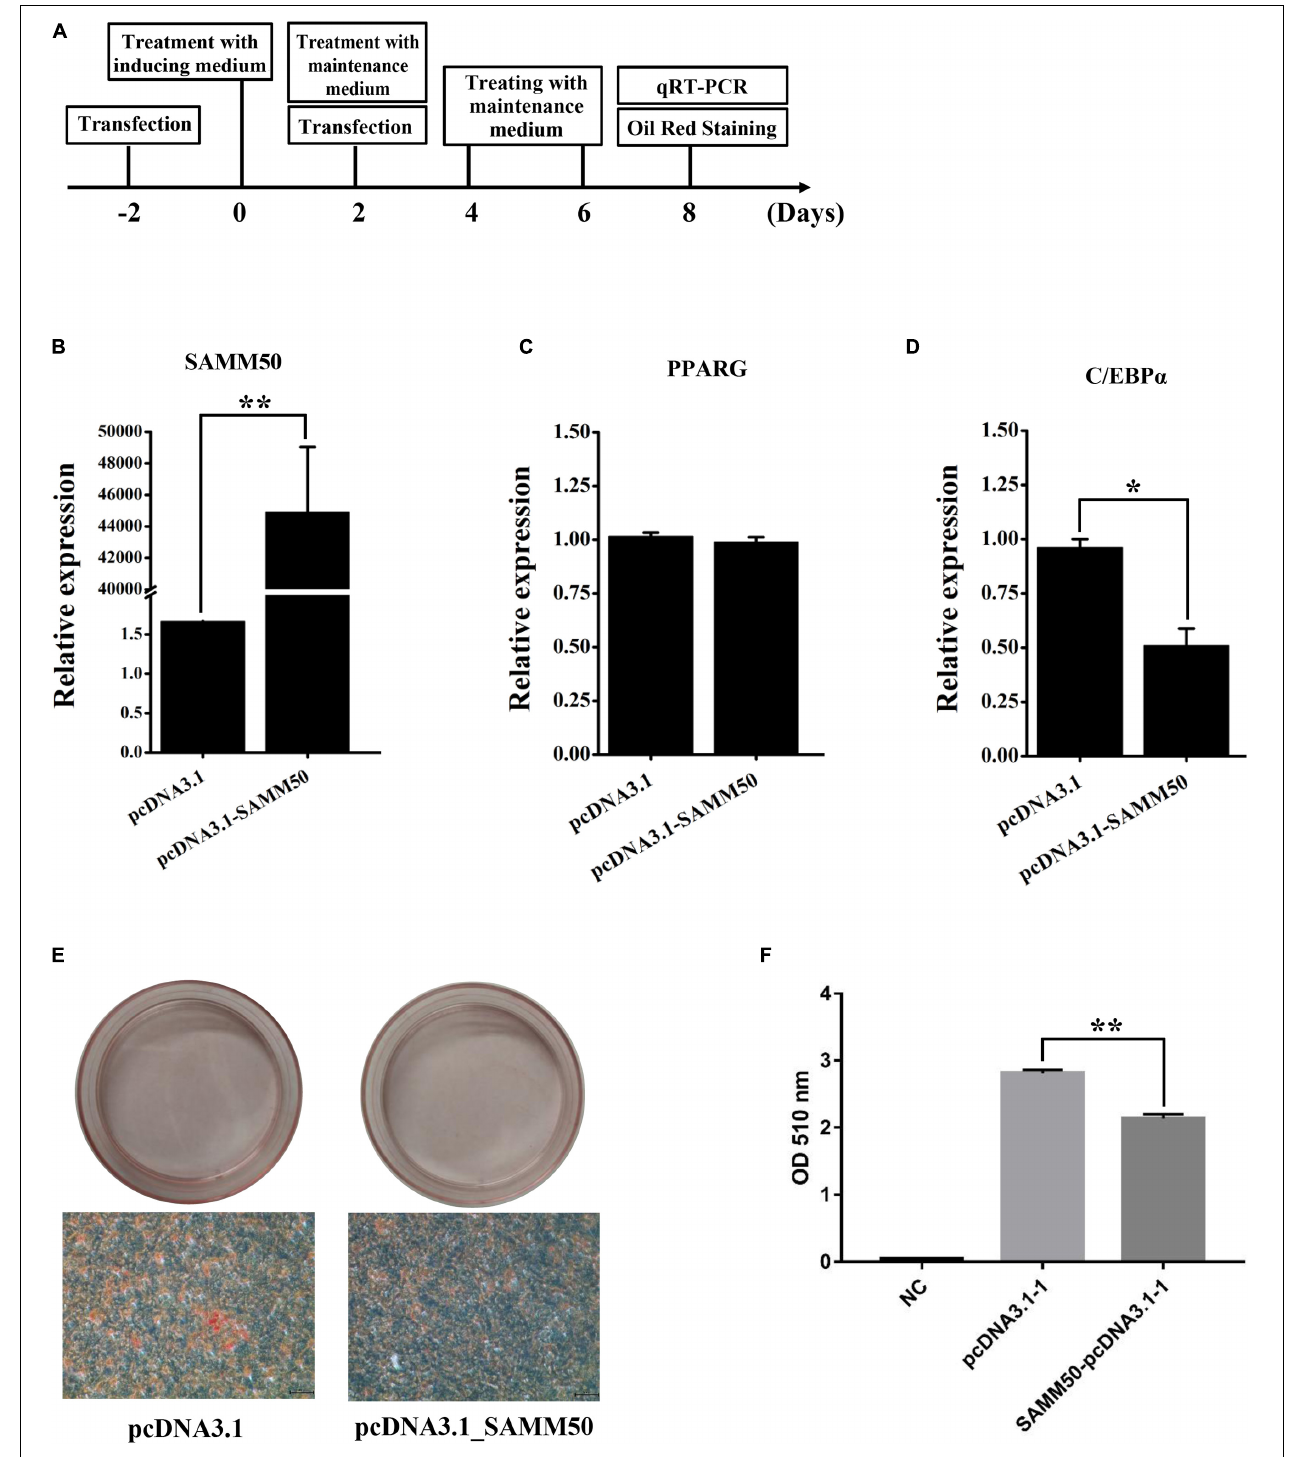
FIGURE 4 | Overexpression of mouse SAMM50 inhibits adipogenic differentiation of 3T3-L1 adipocytes. (A) Strategy of SAMM50 overexpression, adipogenic differentiation, and Oil Red O staining in 3T3-L1 adipocytes. (B–D) RNA expression of SAMM50, PPARG, and C/EBP α 48 h after transfection. GAPDH was used to normalize the expression level of the candidate gene in 3T3-L1 cells. The cycle threshold (2 − (cid:49)(cid:49) Ct ) method was used to calculate the relative expression level of the candidate gene. (E) Images of Oil Red O staining in 3T3-L1 cells transfected with pcDNA3.1 and pcDNA3.1-SAMM50 on day 8 of adipogenic differentiation. Scale bar, 200 µ m. (F) Histogram showing the quantitation of Oil Red O staining by spectrophotometry. NC, negative control. Data are presented as the mean ± SD ( n = 3; * p < 0.05; ** p < 0.01).